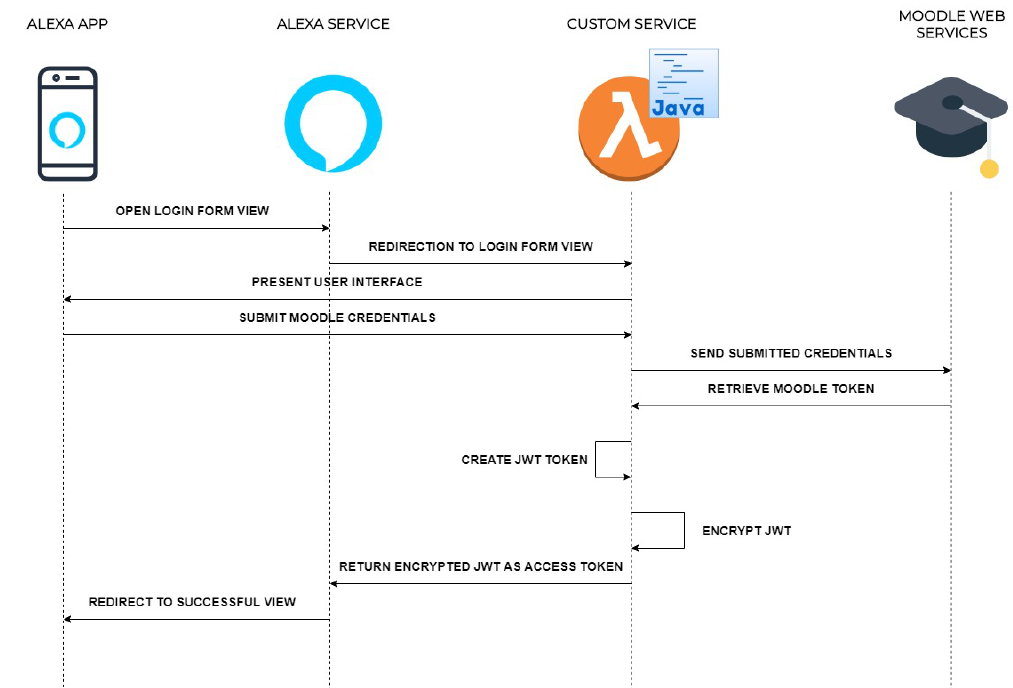
Figure 7. Flow diagram for Alexa access token exchange (Source: own authors’